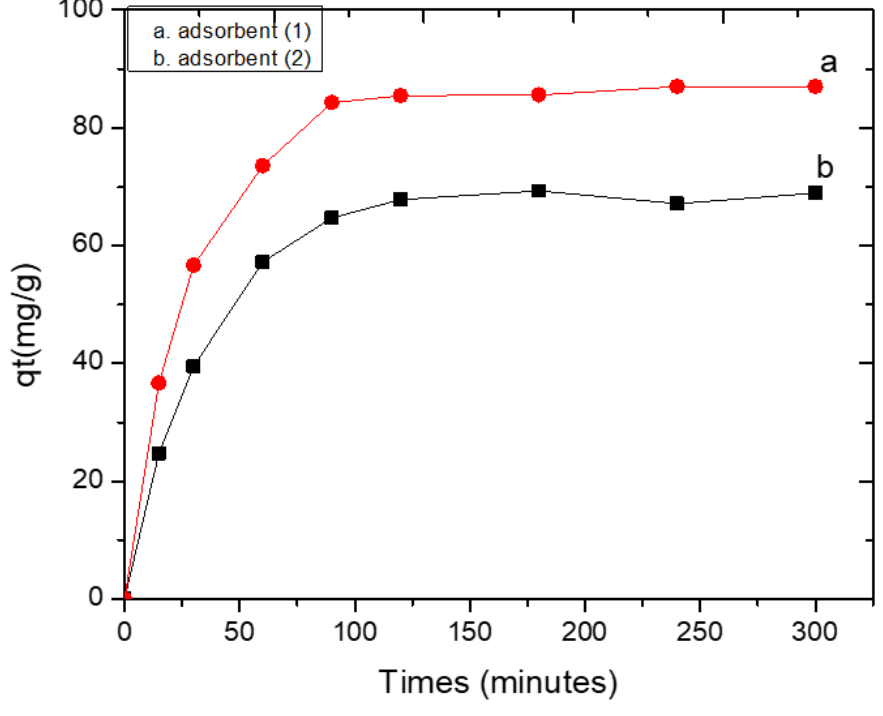
Figure 15. Kinetic adsorption of Pb(II) on adsorbent 1 (a) and adsorbent 2 (b) as a function of contact time (pH 6.5 ± 0.2, initial metal concentration = 20 mg / L, dosage = 50 mg / 50 mL, mixing rate = 50 rpm, T = 25 °C).